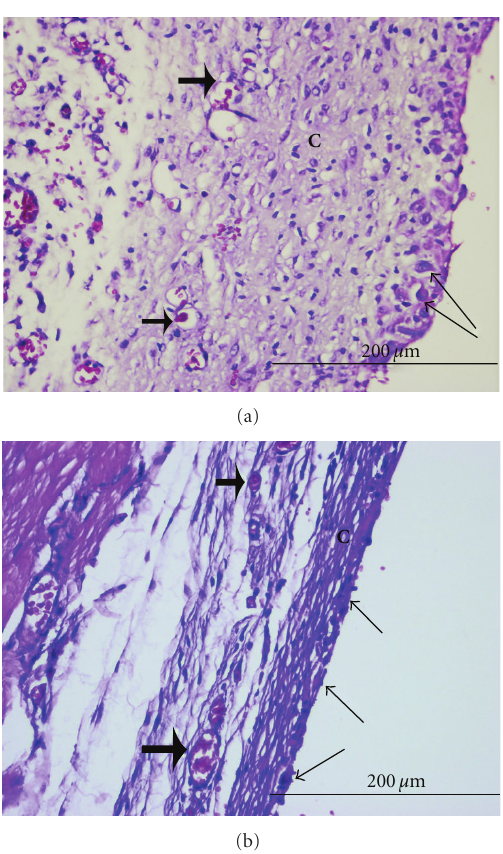
Figure 2: Histological appearance of PP (a) and PP-PEG-4000 (b) polymers. (H&E staining, 40x magnification.) Notice thick capsule (C) around pure polypropylene sample compared to graft copolymer. New blood vessels (thick arrow) are in majority in PP, and giant cell (thin arrow) count is prominent in PP-PEG-4000.